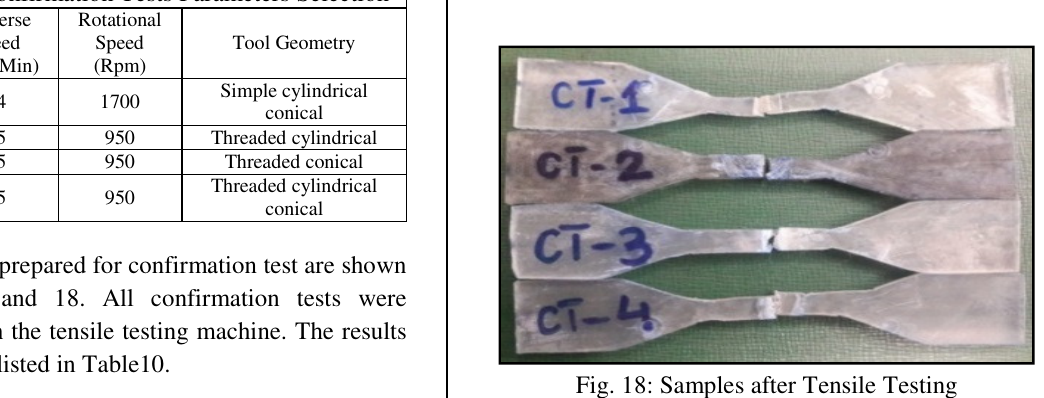
Table 9: Confirmation Tests Parameters Selection